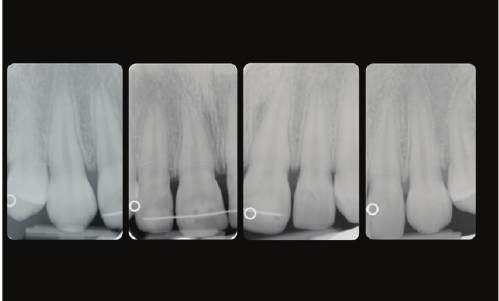
Figure 5: Elimination of secondary flap. Note the immediate increase in crown length.